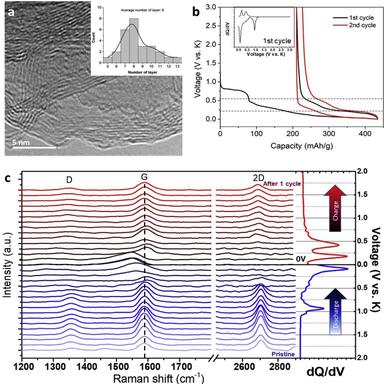
Potassium ion storage in graphitized carbon. (a) TEM image of CNF-2800; (b) Voltage profile of CNF-2800 at the current density of 25 mA/g, inset is the dQ/dV plot; (c) Selective in-situ Raman spectra of CNF-2800 with corresponding dQ/dV plot.